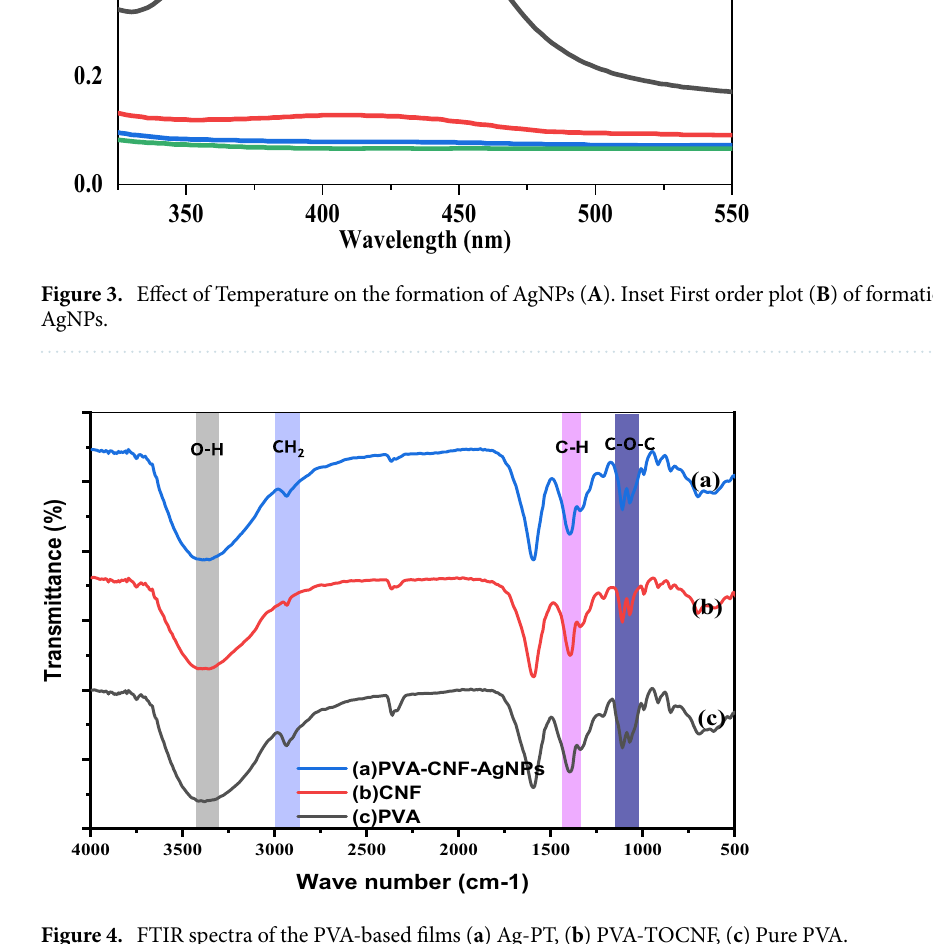
Figure 4. FTIR spectra of the PVA-based films ( a ) Ag-PT, ( b ) PVA-TOCNF, ( c ) Pure